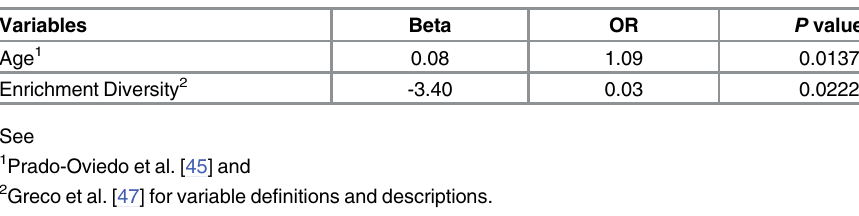
Table 8. Multi-variable assessment of cyclicity in African female elephants using repeated measures logistic regression. OR: Odds